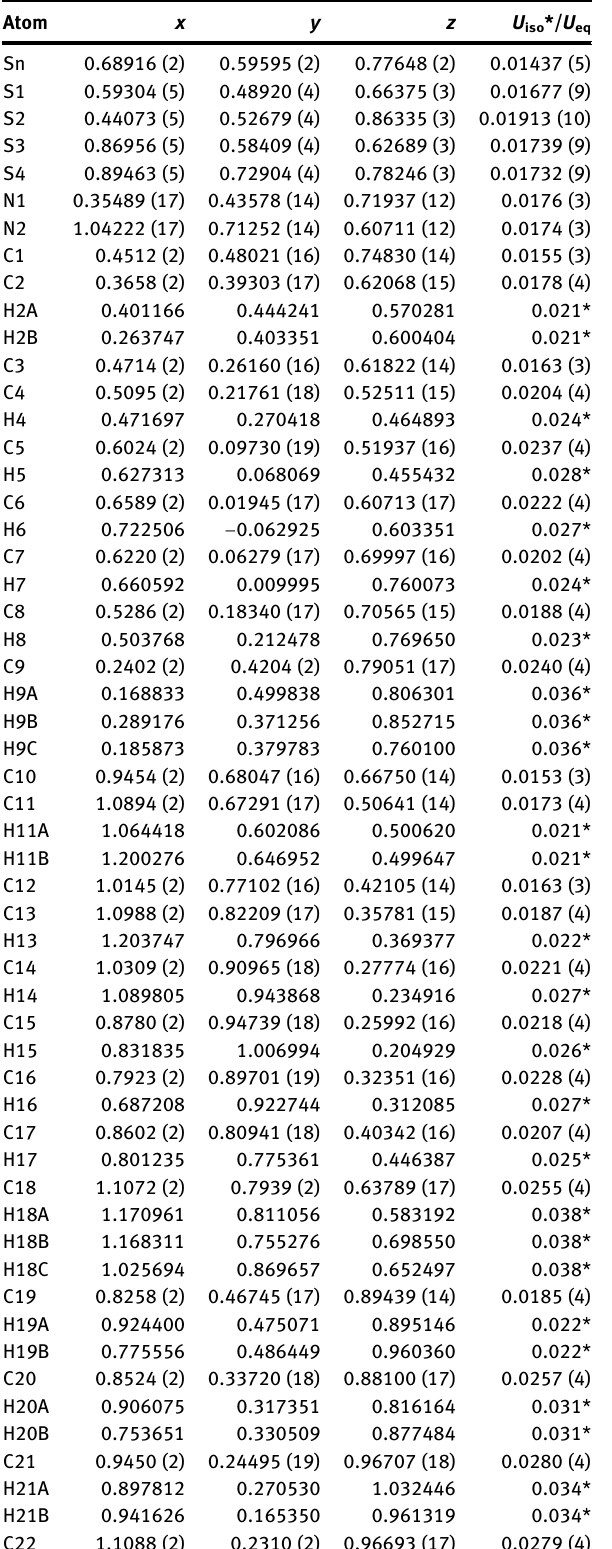
Table  : Fractional atomic coordinates and isotropic or equivalent isotropic displacement parameters (Å 